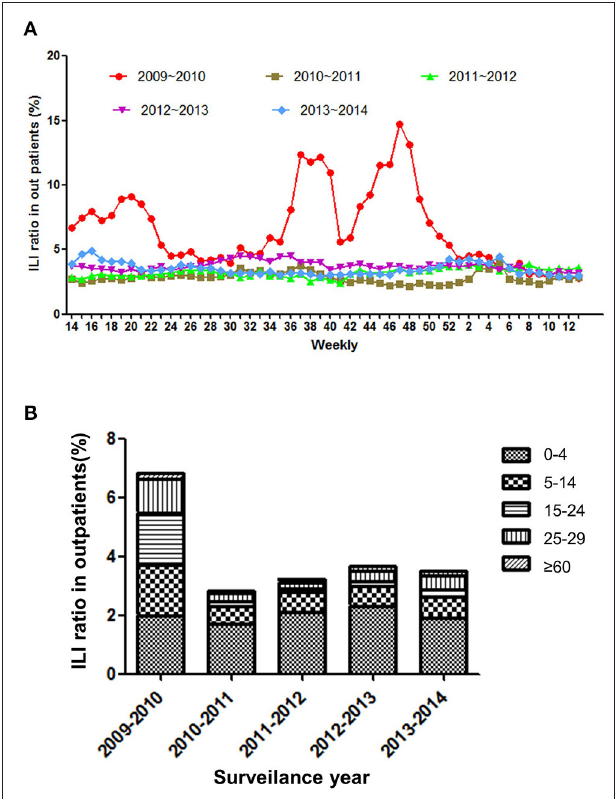
FIGURE 1 | (A) The weekly ratio of ILI outpatients from 2009–2014. (B) The incidence of ILI outpatients by age group from 2009 −